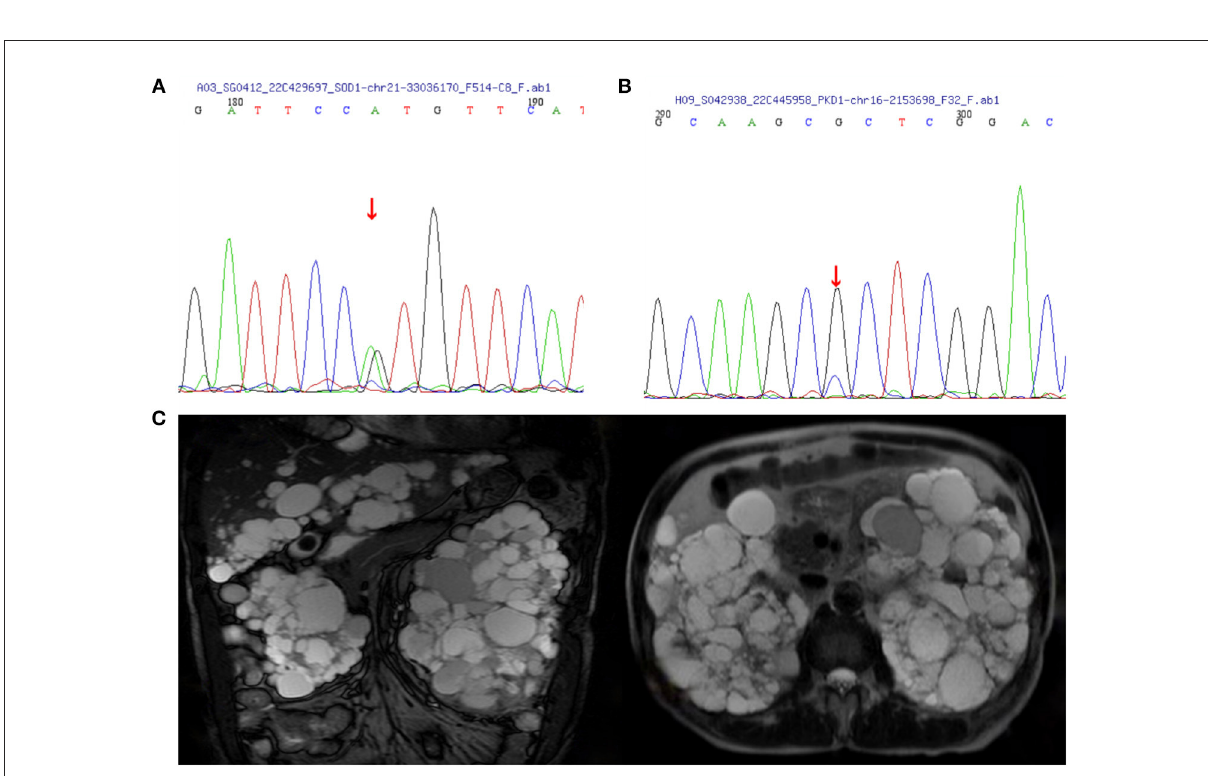
FIGURE2 Images of polycystic kidney disease and sanger sequence. (A) SOD1:c.140(exon2)A > G. (B) PKD1:c.8360(exon23)G > C. (C) MRI images of the case IV-3 associated with polycystic liver disease and polycystic kidney